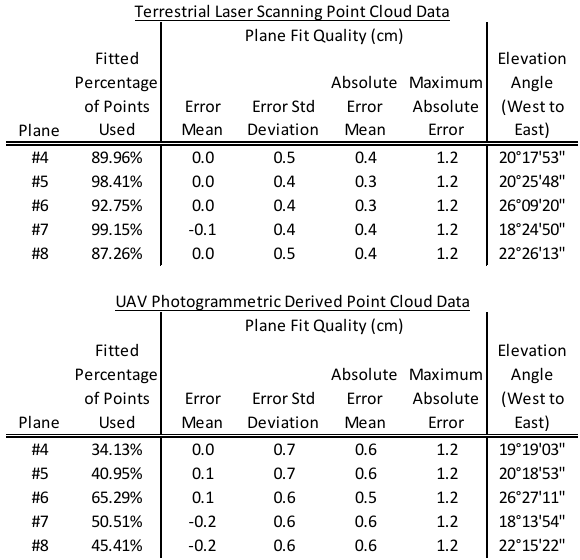
Table 4. Plane fitting results for UAV and TLS for building 2 of Figure 6.